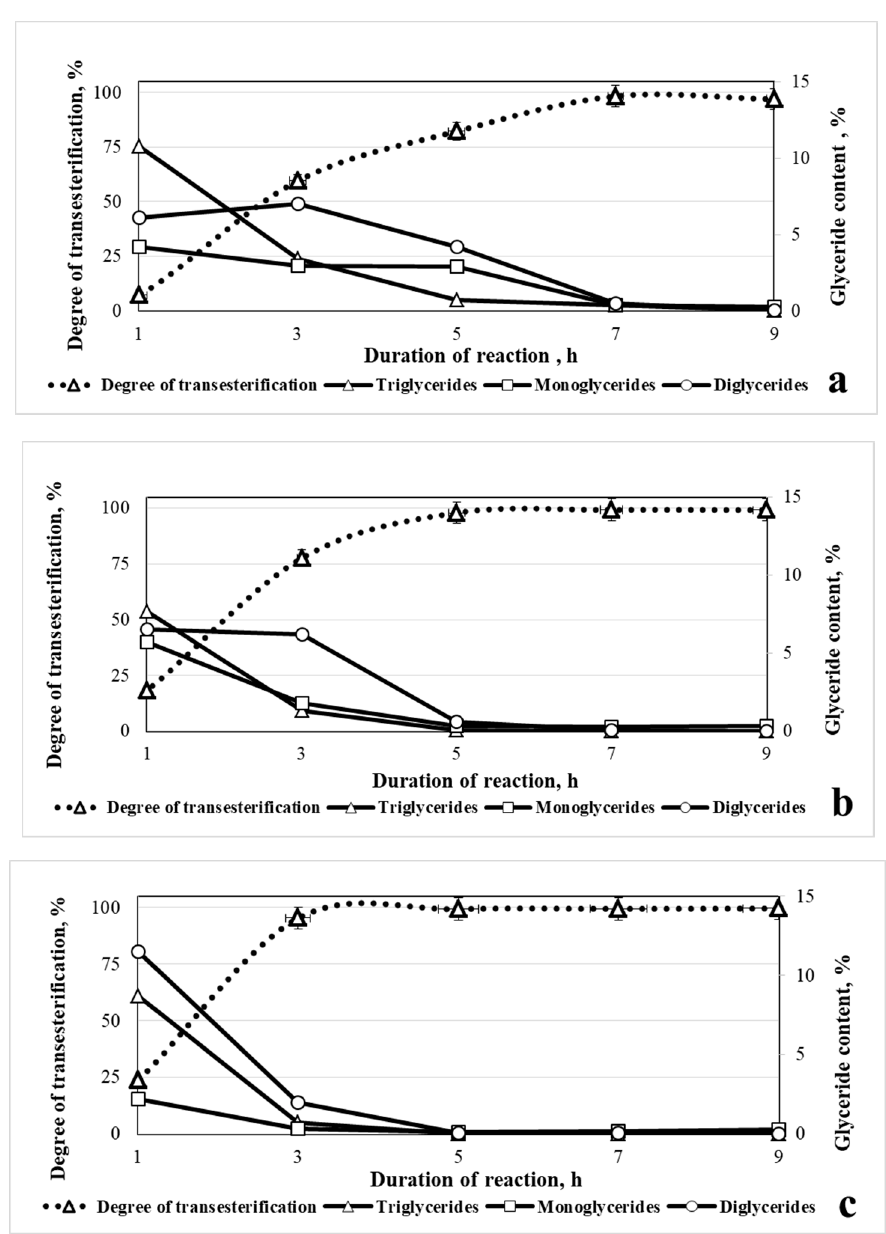
Figure 2. The temperature of the reaction: ( a ) 25 °C, ( b ) 30 °C and ( c ) 40 °C. The degree of transesterification (vertical (value) axis) and the glyceride content (secondary vertical (value) axis) dependence on the reaction duration and temperature when the oil-to-ethanol molar ratio is 1:5 and the lipase (Lipozyme LT IM) concentration is 7%.